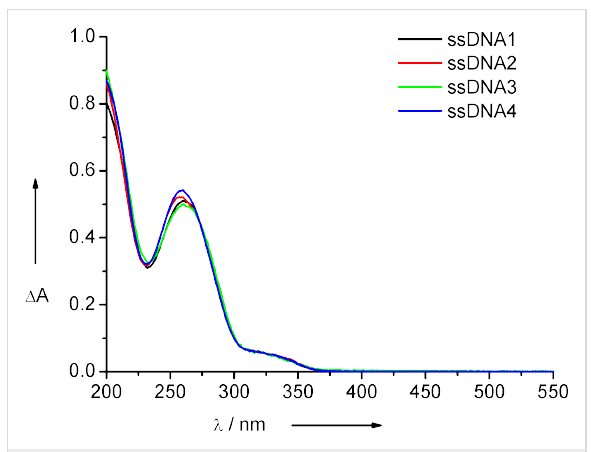
Figure 3: UV–vis absorption spectra of ss DNA1 –ss DNA4 (2.5 μ M in 50 mM Na–Pi buffer, pH 7, 250 mM NaCl,